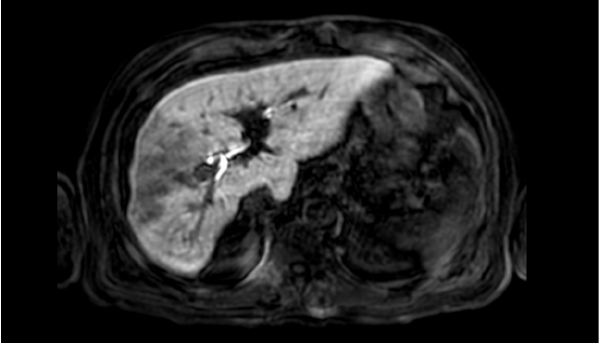
Figure 2. Hepatospecific magnetic resonance imaging scan confirmed the presence of a 18 × 13 mm nodular lesion in the V hepatic segment with satellite micronodules associated with V–VIII sectoral portal branch thrombosis.